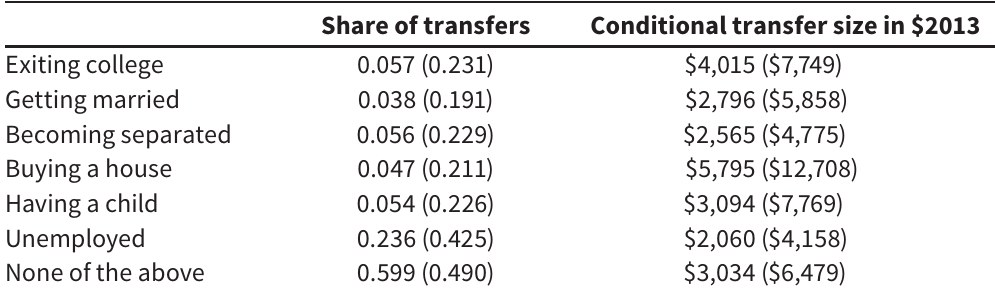
Share of observed family transfers concurrent with life events, heads of household and spouses aged 19–59 years, 1976–2013 PSID Share of